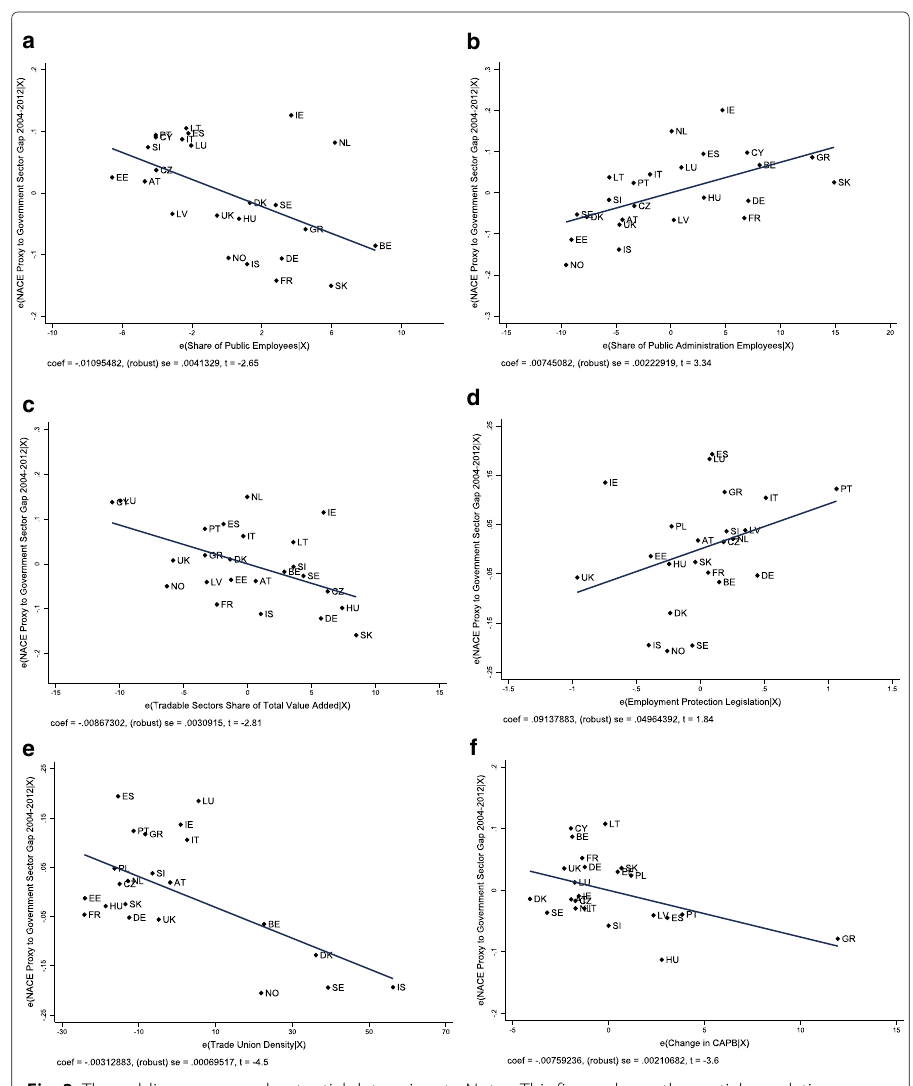
Fig. 3 The public pay gap and potential determinants. Notes: This figure shows the partial correlations between the public sector pay gap and country characteristics. Panels a to c show partial correlations with characteristics linked to the government monopolistic power in the provision of public services; see column (2) of Table 2. Specifically, panels a , b , and c show the partial correlation of the size of the public sector (share of public sector employees), the composition of the public sector (specialization in public goods), and the exposure to international trade (specialization in tradable goods), respectively. Panels d and e show the correlation (in deviations with respect to the mean) between labor market institutions and the public sector pay gap. Panel d shows the correlation of an index of employment protection legislation (column (2) of Table 3) and panel e of an index of trade union density (column (3)). Finally, panel f shows the correlation (in deviations with respect to the mean) between improvements in the CAPB during the crisis and changes in the public sector pay gap; see column (1) of Table 4. Improvements in the CAPB are computed as the CAPB in 2012 minus the minimum in the period 2007–2011. Changes in the public sector pay gap correspond to the same